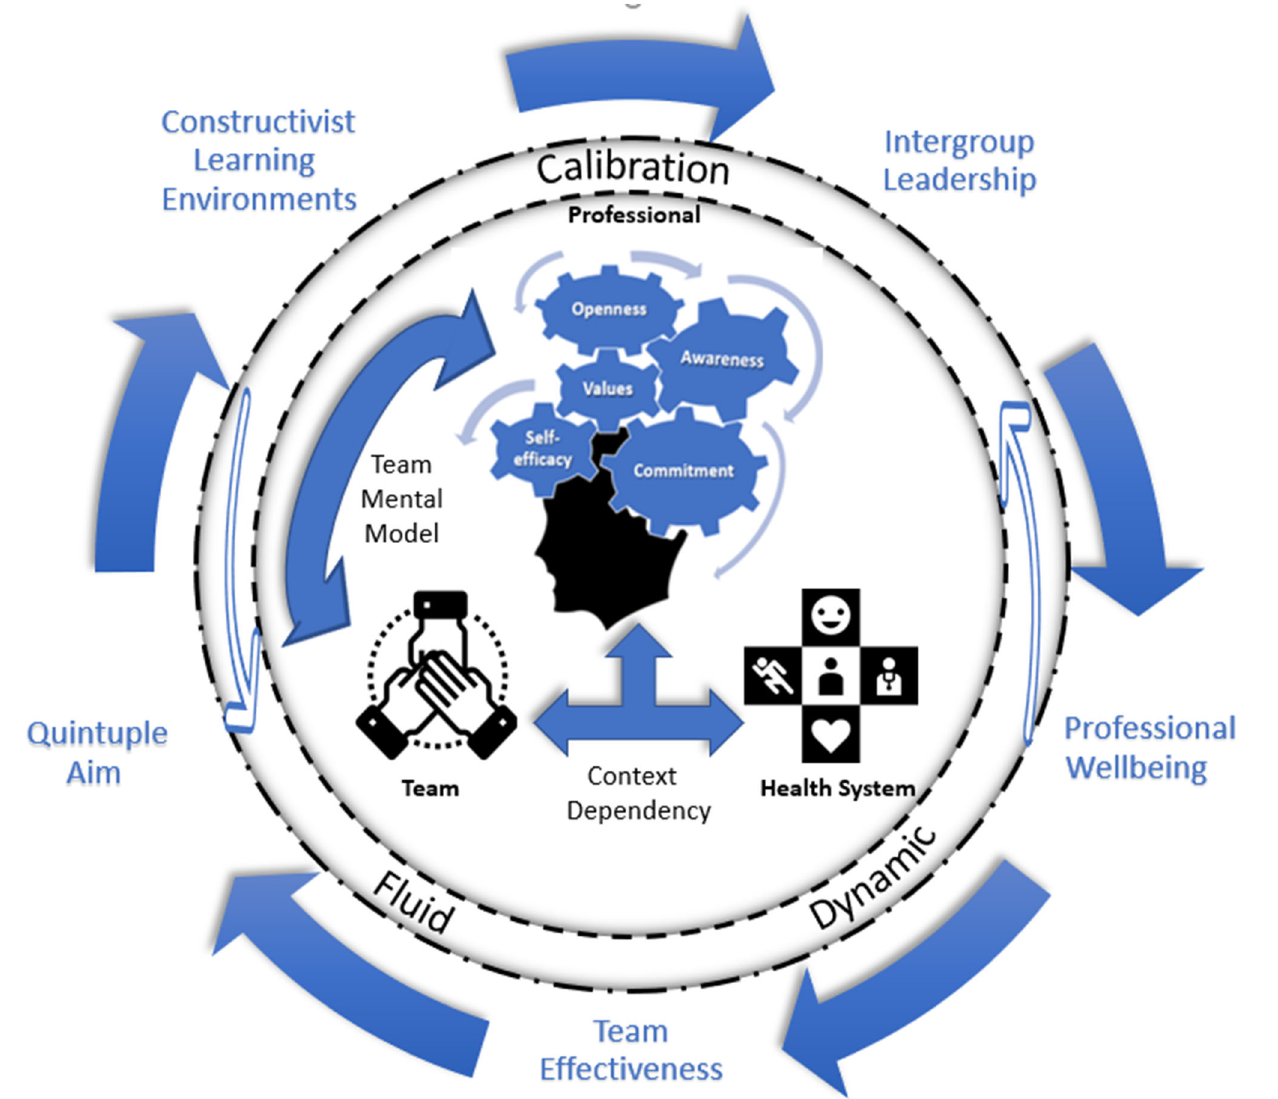
Figure 2. Conceptual framework visualizing the interconnectedness of the antecedents, attributes and consequences of IPI. The inner circle shows the five content-related attributes that need to be integrated into a professional’s identity as well as illustrates the reciprocal influence between professionals through a team mental model, while emphasizing the context-dependency of the former in the health system. The middle ring argues that professionals, teams and eventually the health system continuously develops in a fluid and dynamic way and through calibration. The outer region encompasses the antecedents ( top part ) which indirectly leads to the consequences ( bottom part ) while both also influence and are influenced by the IPI development depicted inside the circle and inferred by the dotted lines.